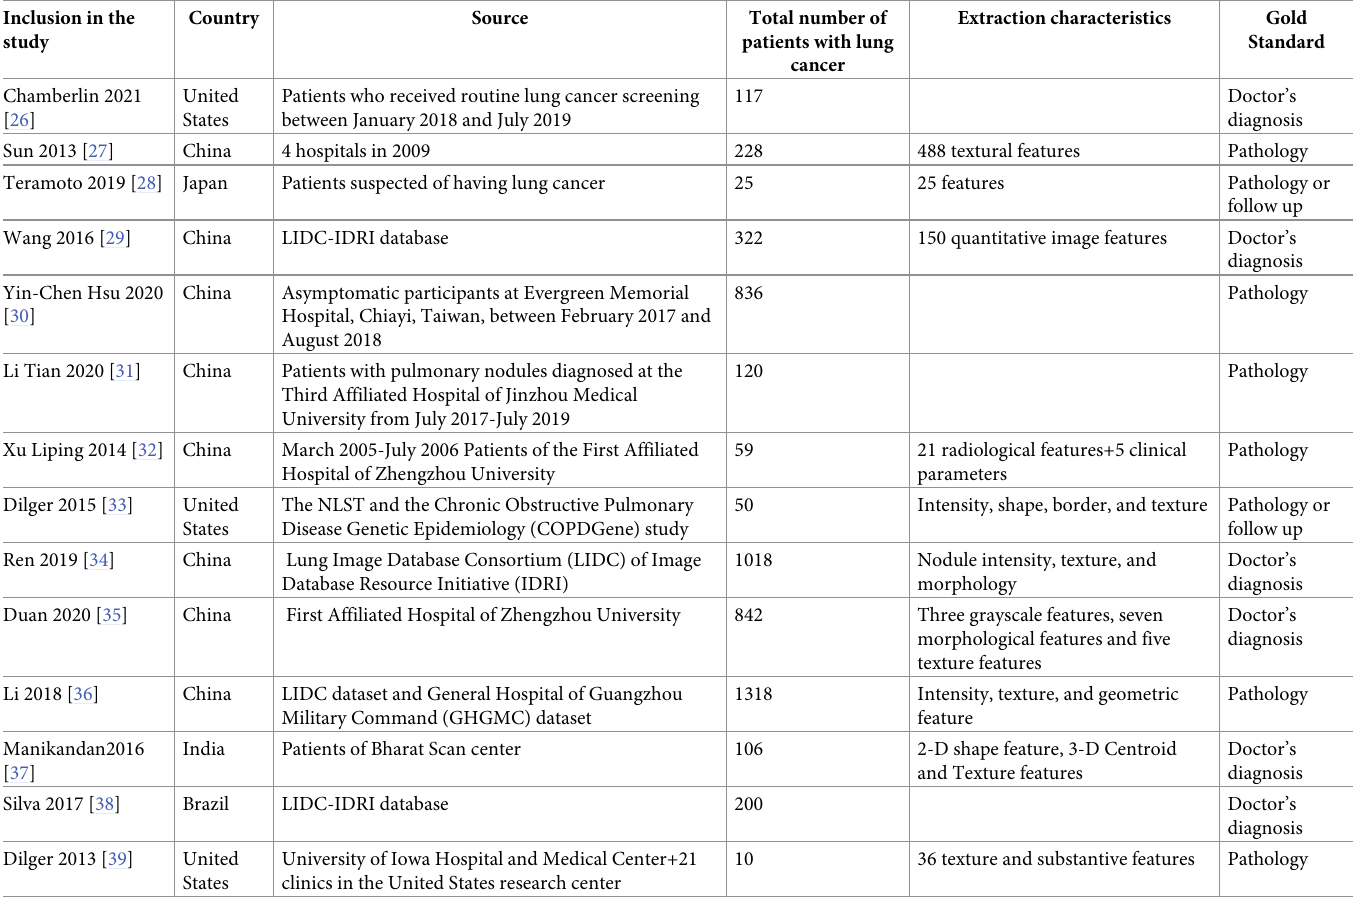
Table 2. Basic characteristics of the included